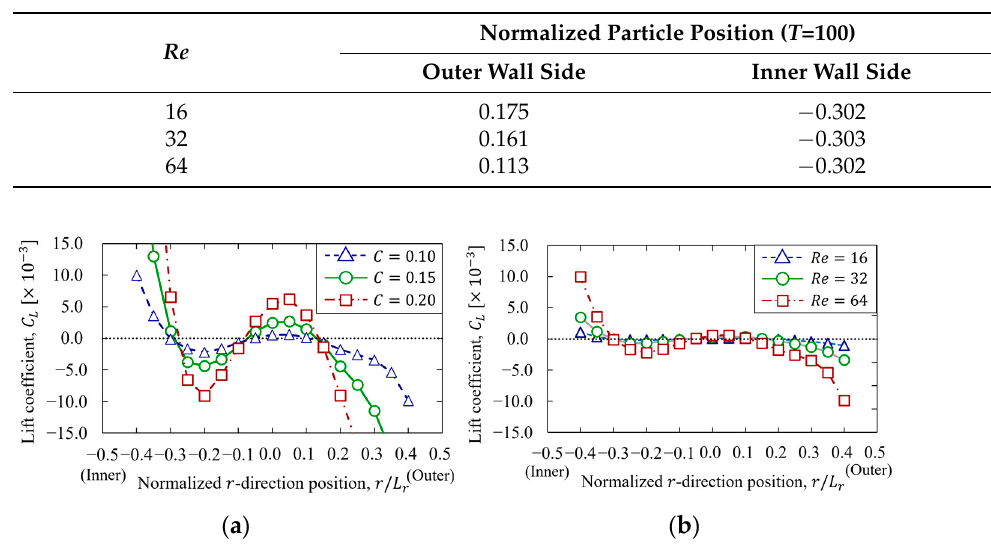
Figure 12. Particle migration for varying Reynolds number 𝑅𝑒 with 𝐶 = 0.10 . ( a ) Particle migra- tion on outer wall side. ( b ) Particle migration on inner wall side. Table 7. Value of particle position at T = 100 for varying Reynolds number Re = 16 ∼ 64 with Table 7. Value of particle position at 𝑇 = 100 for varying Reynolds number 𝑅𝑒 = 16 ~64 with C = 0.10. 𝐶 = 0.10 .